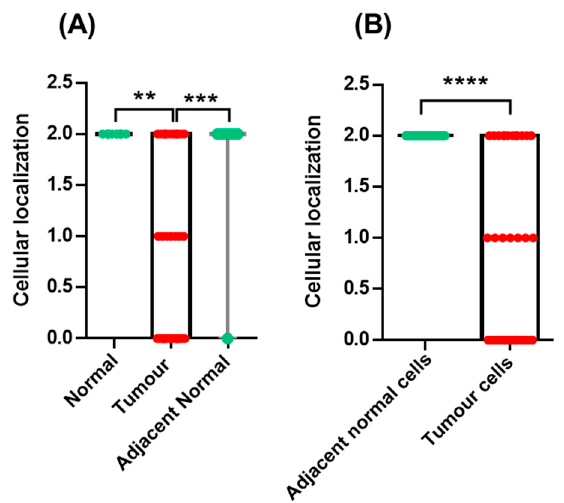
Figure 4. Gal-3 cellular localization in normal, tumour and adjacent-normal prostate tissues ( A ) and in co-localized adjacent-normal cells and tumour cells ( B ). The cytoplasmic location of Gal-3 is indicated by 1, while the cytoplasmic and nuclear location is indicated by 2. (** p < 0.01; *** p < 0.001; **** p < 0.0001).